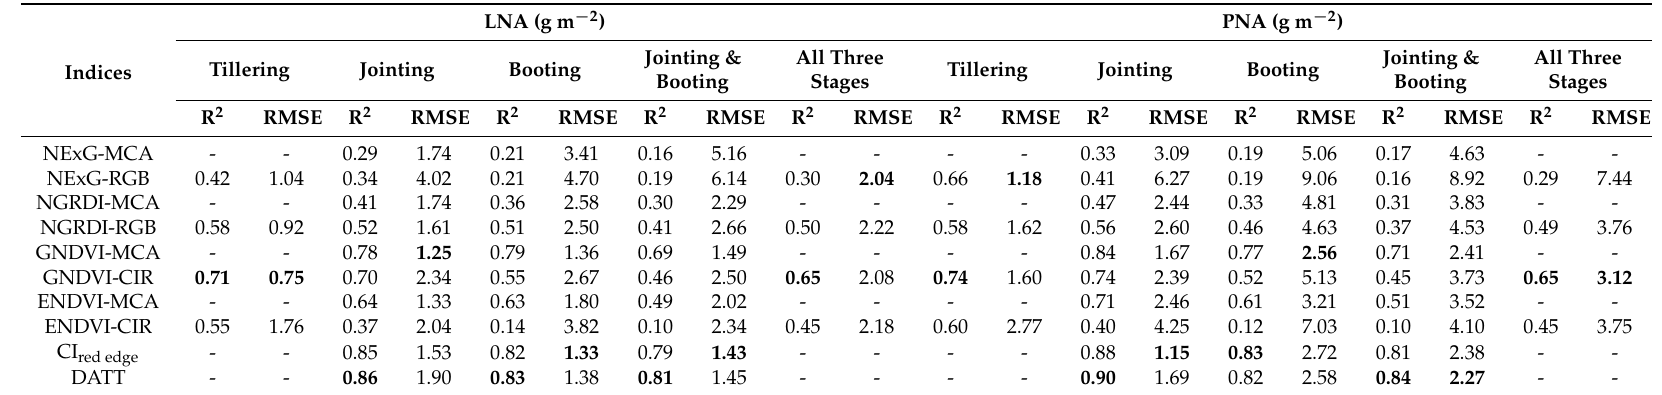
Table 4. Accuracy assessment with the determination coefficient (R 2 ) and root mean squared error (RMSE) values for the estimation of rice leaf N accumulation (LNA, g m − 2 ) and plant N accumulation (PNA, g m − 2 ) with vegetation indices in